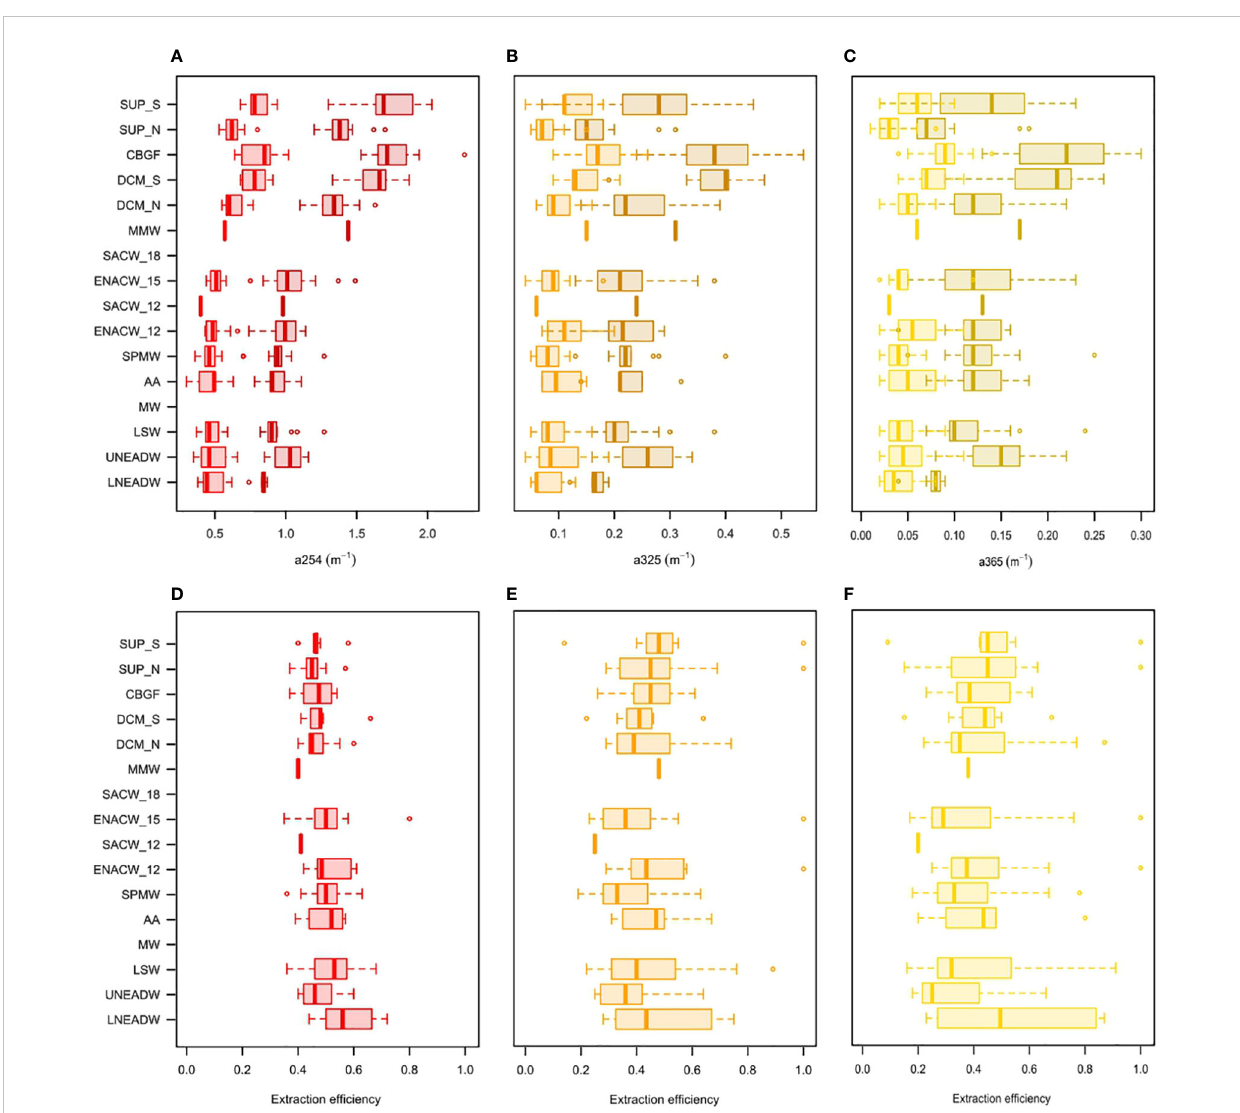
FIGURE 4 (A) a 254 , (B) a 325 and (C) a 365 of the bulk and SPE samples and (D) a 254 , (E) a 325 , (F) a 365 extraction ef fi ciency, for each water body. Dark and light values represent bulk and SPE values, respectively. The boxes represent the interquartile range of the data, where the dark line represents the median. The whiskers represent the minimum and maximum values of the range, excluding the outliers, which are represent by dots. The y-axis represents the water bodies and WTs, water bodies were ordered by its position from the CVF: Waters south of CVF and Water north of CVF, while WTs were ordered by depth (Table S1) to obtain the water column pro fi le. Water bodies were: Surface North (SUP_N, 5.1 ± 0.4 Dbar), DCM North (DCM_N, 80.1 ± 17.0 Dbar), Surface South (SUP_S, 4.7 ± 0.7 Dbar), DCM South (DCM_S, 35.2 ± 15.0 Dbar) and The Cape Blanc Giant Filament (CBGF, 16.5 ± 15.9 Dbar). WTs were: Madeira Mode Water (MMW, 55.2 ± 21.2 Dbar), Eastern North Atlantic Central Water of 12°C (ENACW_12, 462.0 ± 63.1 Dbar) and 15°C (ENACW_15, 298.2 ± 14.4 Dbar), South Atlantic Central Water of 12°C (SACW_12, 345.3 ± 61.6 Dbar) and 18°C (SACW_18, 99.2 ± 55.8 Dbar), Subpolar Mode Water (SPMW, 749.3 ± 18.6 Dbar), Antarctic Intermediate Water (AA, 910.3 ± 101.4 Dbar), Mediterranean Water (MW, 1498.1 ± 54.5 Dbar), Labrador Sea Water (LSW, 1519.9 ± 44.5 Dbar) and the Upper (UNEADW, 3048.9 ± 141.4 Dbar) and Lower North East Atlantic Deep Water (LNEADW, 3822.6 ± 114.4